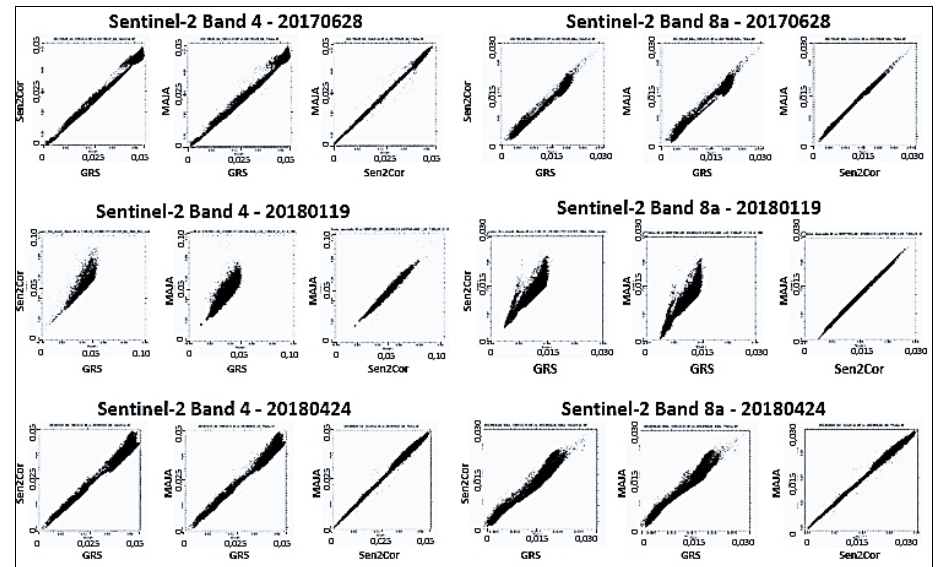
Figure 3 - Scattering diagrams of bands 4 and 8a S-2 reflectances and for the three post processing